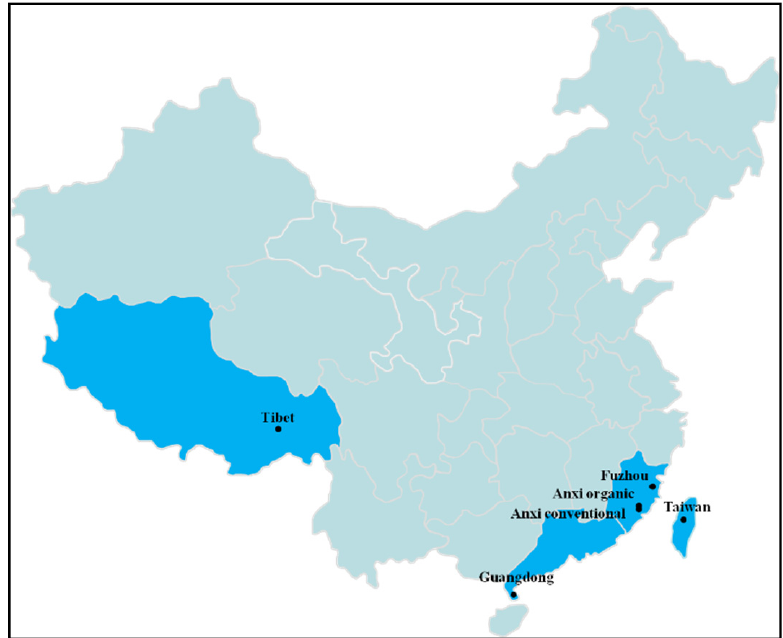
Figure 1. Distribution map of soil sampling points in the study area. Sampling site: Taiwan: N: 23°63 ′ 15 ″ , E: 120°63 ′ 01 ″ ; Tibet: N: 30°10 ′ 50 ″ , E: 94°54 ′ 12 ″ ; Guangdong: N: 20°31 ′ 10 ″ , E: 110°14 ′ 56 ″ ; Fuzhou: N: 27°42 ′ 50 ″ , E: 118°00 ′ 06 ″ ; Anxi organic: N: 25°00 ′ 05 ″ , E: 117°52 ′ 19 ″ ; Anxi conventional: N: 24°59 ′ 60 ″ , E: 117°52 ′ 21 ″ .